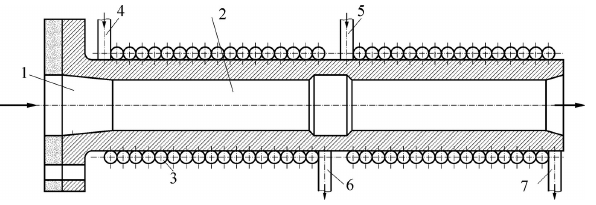
Figure 4: Outside calibrator for polymer coating of steel bars 1, 2 – the calibrator’s sleeve, 3 – water pipe coil; and 4, 5, 6, 7 – water flow directions